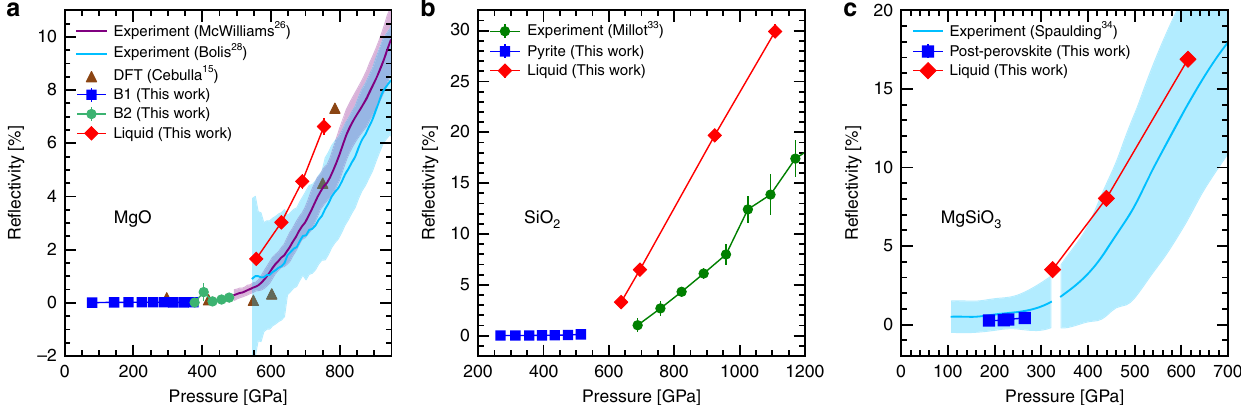
Fig. 4 532 nm re fl ectivity along the principal Hugoniot. We plotted our calculated re fl ectivity (with a one- σ error bar) in the different phases of a MgO, b SiO 2 , and c MgSiO 3 along their respective Hugoniot curves as described in Fig. 1. We added previous numerical results for MgO 15 , and systematically compared with available experimental results 26,28,33,34 including their